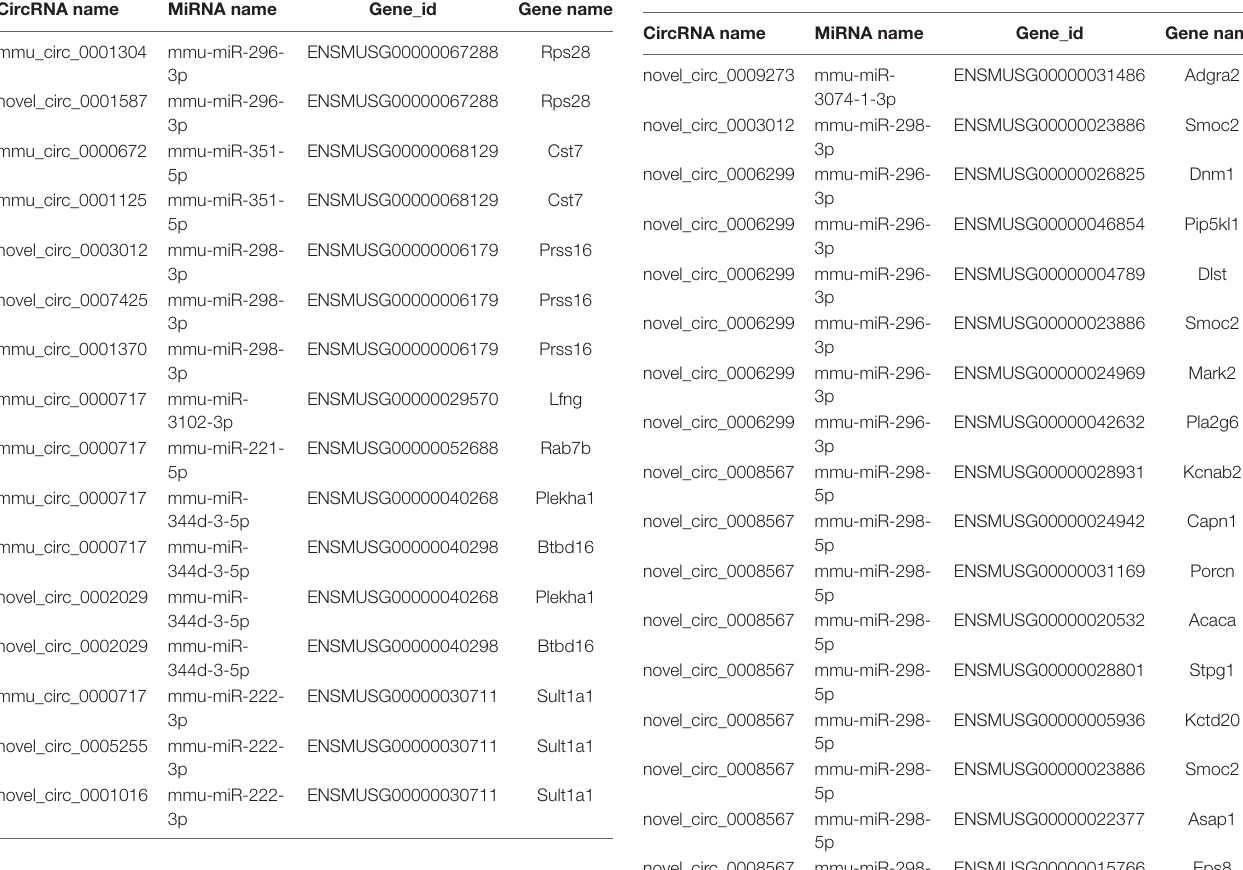
TABLE 4 | CircRNA-ceRNA networks in AD. TABLE 5 | CircRNA-ceRNA networks in cGMP-PKG, cAMP, and Hippo signaling